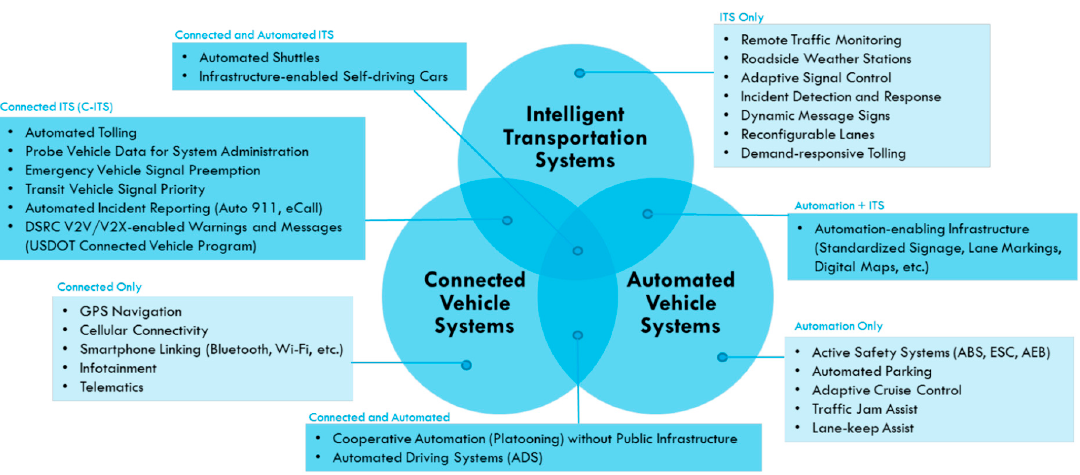
Figure 1. Relating intelligent transportation systems (ITS), automated vehicle (AV) systems, and connected vehicle (CV) systems [3]. USDOT = U.S. Department of Transportation; DSRC = Dedicated Short Range Communications; V2V = Vehicle-to-Vehicle; V2X = Vehicle-to-Everything; GPS = Global Positioning System; ABS = Anti-Lock Brake Systems; ESC = Electronic Stability Control; AEB = Automated Emergency Braking.